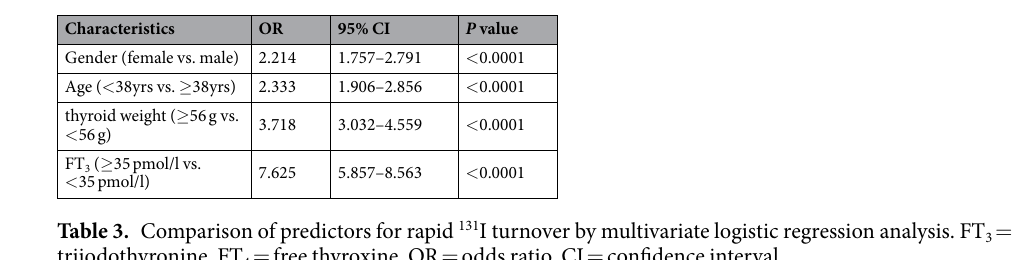
Table 3. Comparison of predictors for rapid 131 I turnover by multivariate logistic regression analysis. FT 3 =